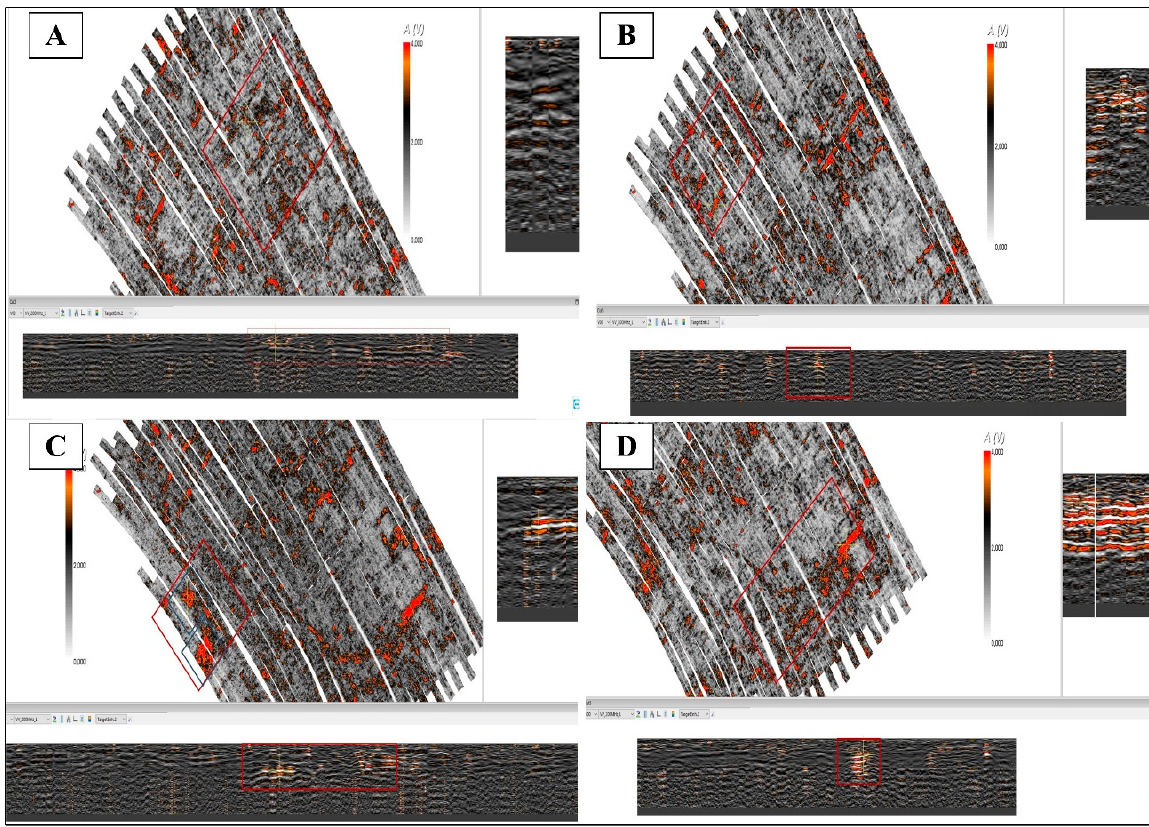
Figure 6. Main alterations of project 2 in GRED HD: ( A ) P2-1; ( B ) P2-2; ( C ) P2-3; ( D )